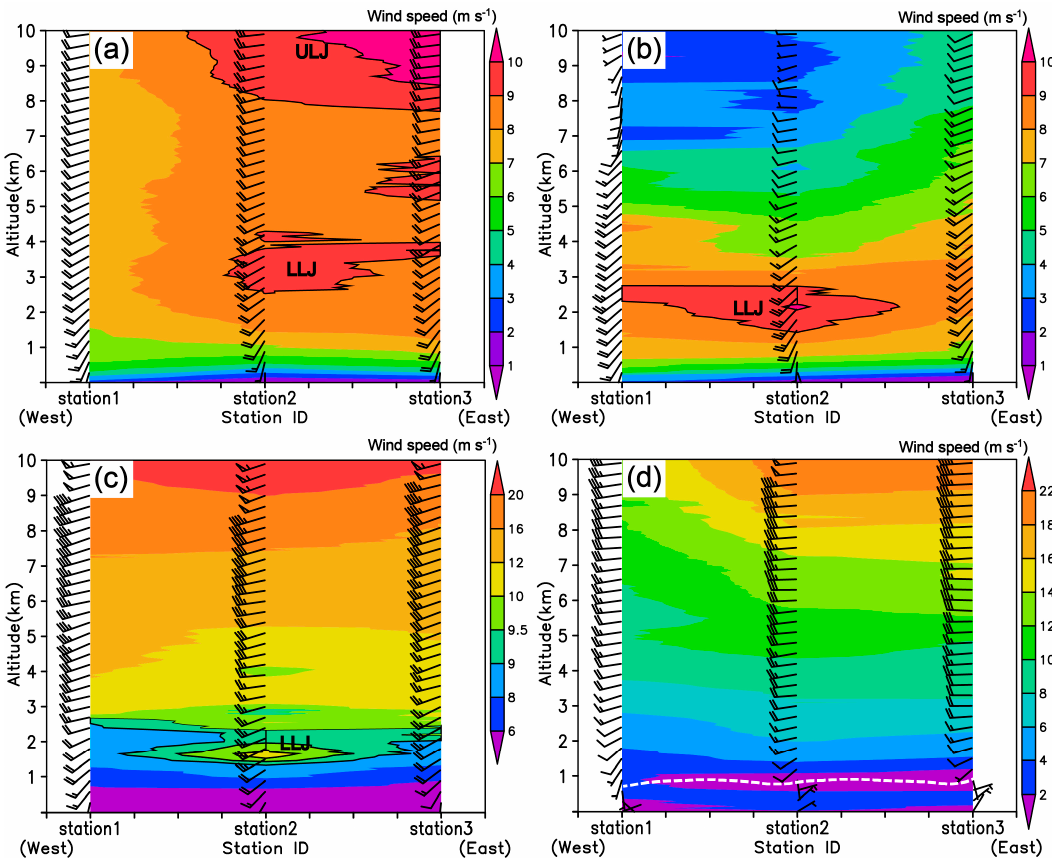
Figure 10. (( a – c ); referred to as wind profiles 1-1, 1-2, and 1-3—WP1-1, WP1-2, and WP1-3) Three types of composite wind profile sections for the OWSRs in the SWLLJ situation and (( d ); referred to as wind profile 2—WP2) the composite wind profile section for the OWSRs in the ACR situation. The color-shaded and vectors are wind speed and vectors (units: m s − 1 ). “station1” indicates the radiosonde station nearby the rainfall location, and “station2” and “station3” indicate the radiosonde stations to the east of “station1” along the orientation of rainfall extension. “LLJ” indicates low-level jet which has been outlined with bold contours, and the dashed line in ( d ) indicates a vertical wind shear boundary.